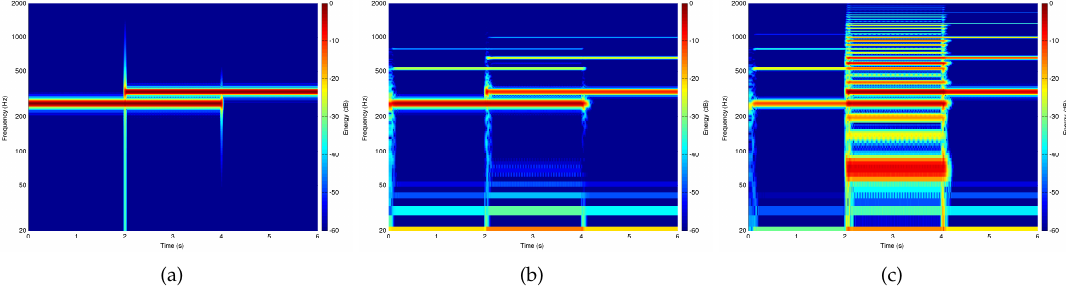
Figure 14. Showing how the Hammondizer mode-wise distortion does not cause intermodulation distortion. ( a ) Input signal; ( b ) Hammondizer with mode-wise distortion; and ( c ) Hammondizer with “global” distortion.